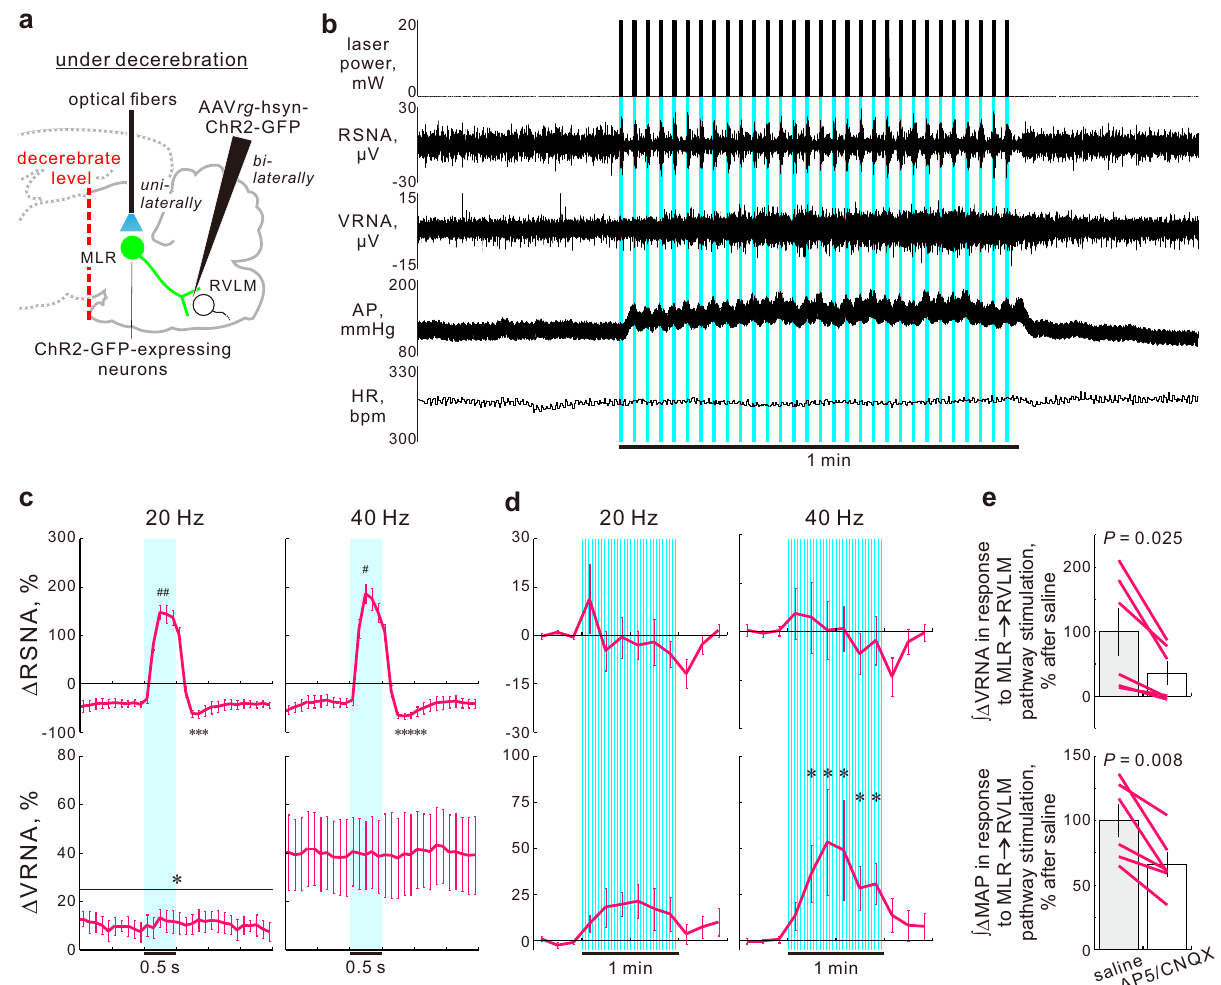
Fig. 3 | MLR → RVLM pathway drives both sympathoexcitation and motor neuroexcitation. a Optogenetic stimulation of MLR → RVLM neurons in una- nesthetized decerebrated rats. b A representative recording during optogenetic stimulation (40Hz) in a ChR2-GFP-expressing decerebrated rat. c , d Time courses after superimposing and averaging analysis ( c 100-ms bins) and throughout optogenetic interventions ( d 10-s bins) of Δ RSNA and Δ VRNA in response to 1-min intermittent stimulation of the MLR → RVLM neurons in ChR2-expressing decere- brated male rats ( n =6). e Effect of glutamate receptor blockades in the RVLM on Δ VRNA and Δ AP responses to 15-s sustained stimulation of MLR → RVLM neurons (40Hz), assessed by their integrated values for 15s, in ChR2-GFP-expressing,